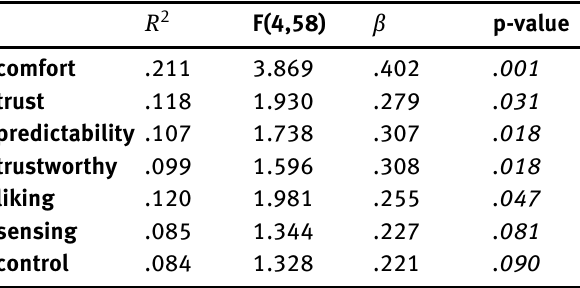
Table 6: Significant and near-significant effects of transparency on the evaluation of the